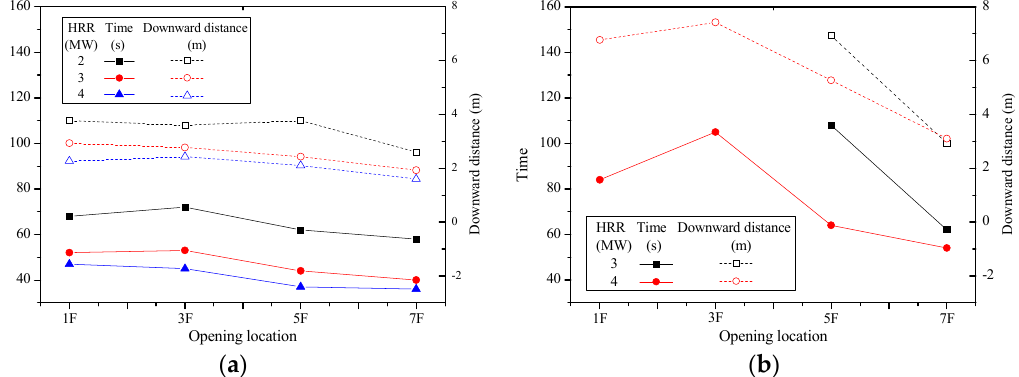
Figure 13. Longest smoke back-layering distance with different open stair doors and wind velocities. ( a ) 3.5 m/s. ( b ) 4 m/s.